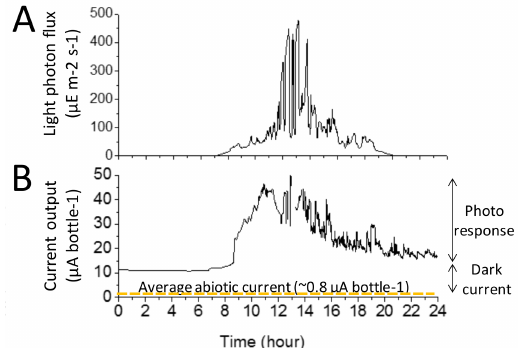
Figure 3. Electrical outputs of a BBV system. ( A ) Illustrative example of the light photon flux falling on the BBV system. ( B ) Illustrative example of the current output generated by a BBV system. The yellow dotted line shows the average current output for the abiotic BBV systems operated without algal cells.